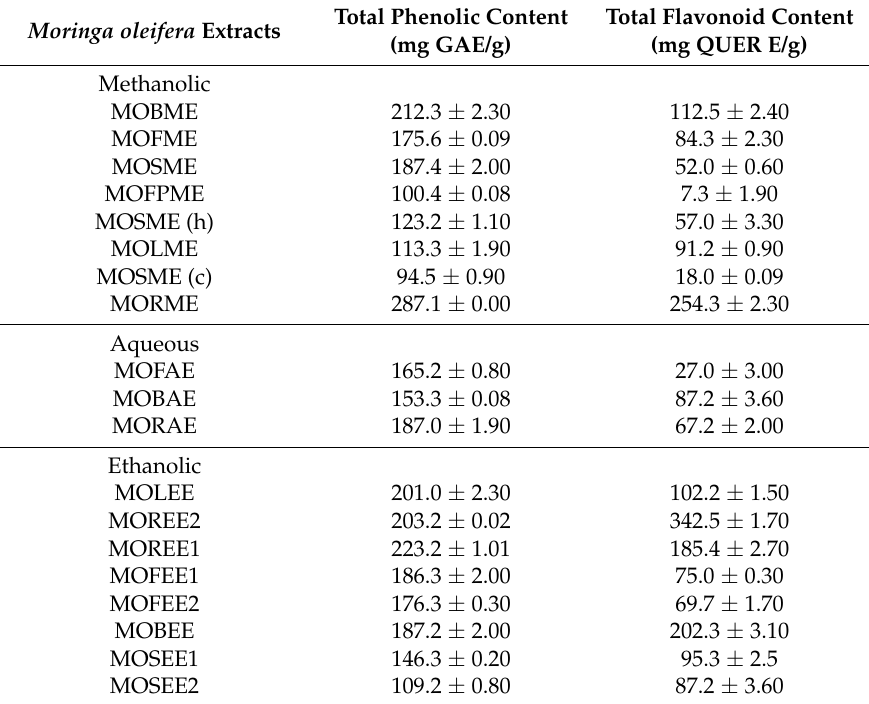
Table 2. Total phenolic and flavonoid content of Moringer oleifera methanolic, aqueous, and ethanolic